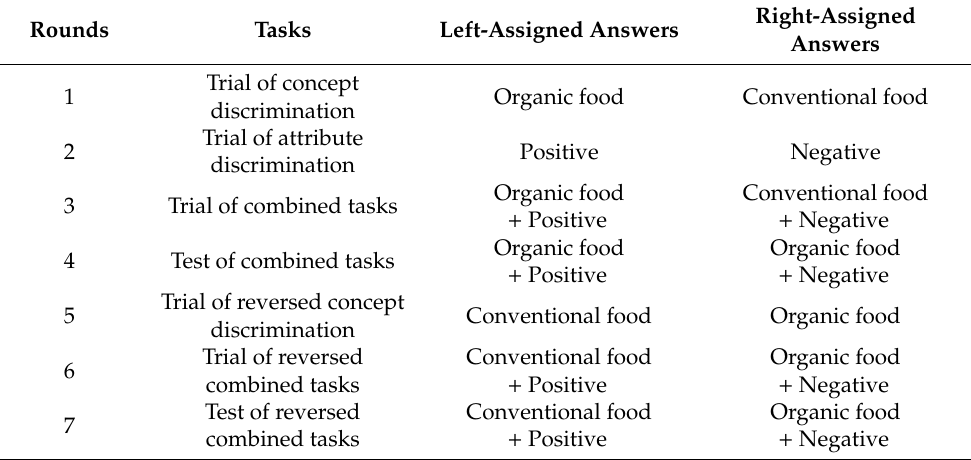
Table 1. Sequence of implicit association test tasks